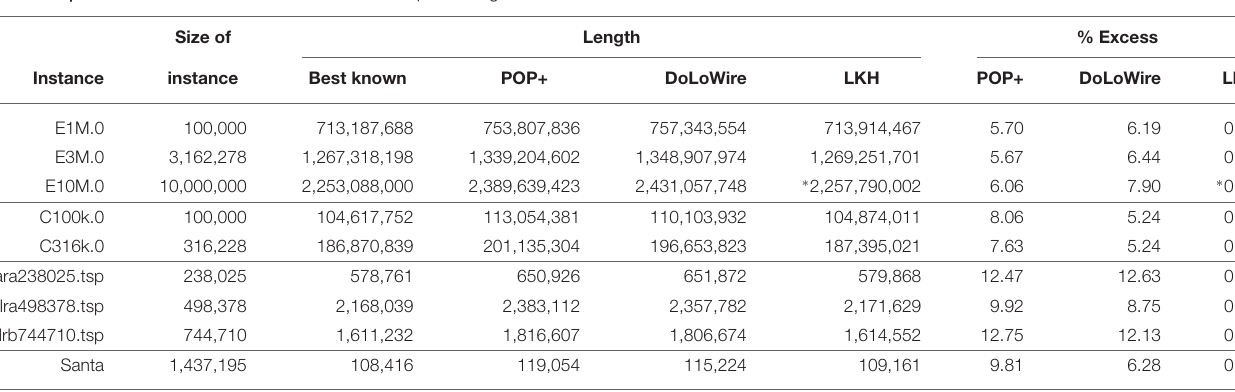
FIGURE 9 | Progress of optimization for DIMACS instances (initial tour with maxCP TABLE 2 | Results for different instances after 60 min of